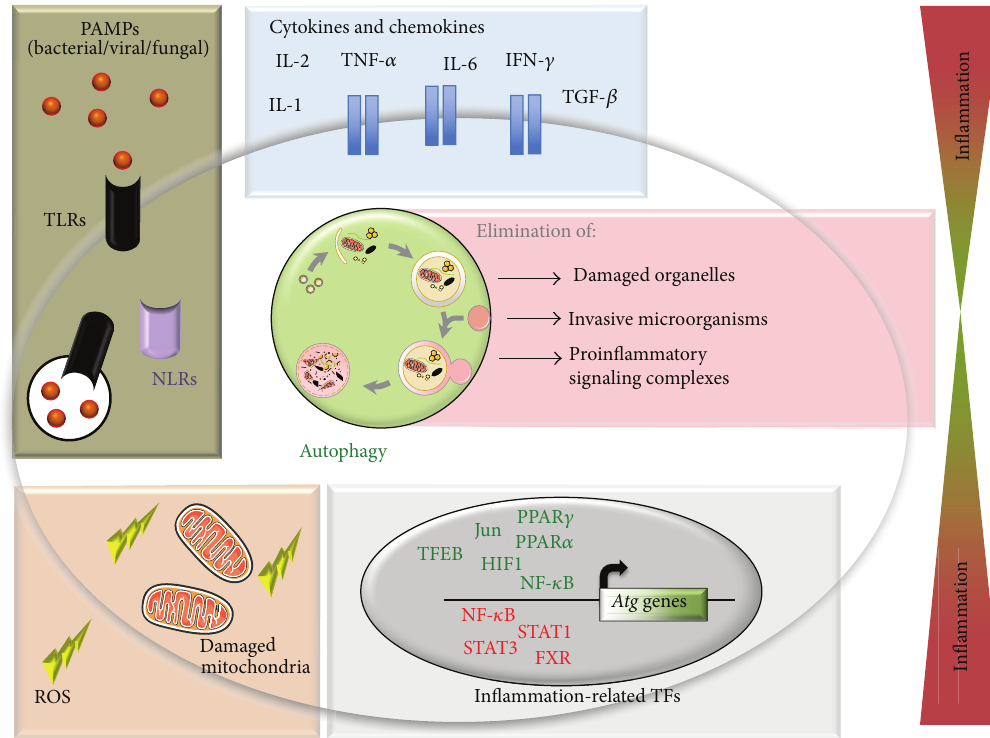
Figure 1: Autophagy and inflammation. By integrating output signals from PRRs (brown box), cytokines, and chemokines (blue box) and ROS (orange box), autophagy regulatory network is able to dynamically respond to inflammation. Transcriptionally, inflammation-related transcription factors shape transcriptional program of autophagy (grey box). Active autophagy reduces inflammation at least by mediating damaged organelles clearance, lowering microorganisms intracellular load and degrading inflammatory mediators (red